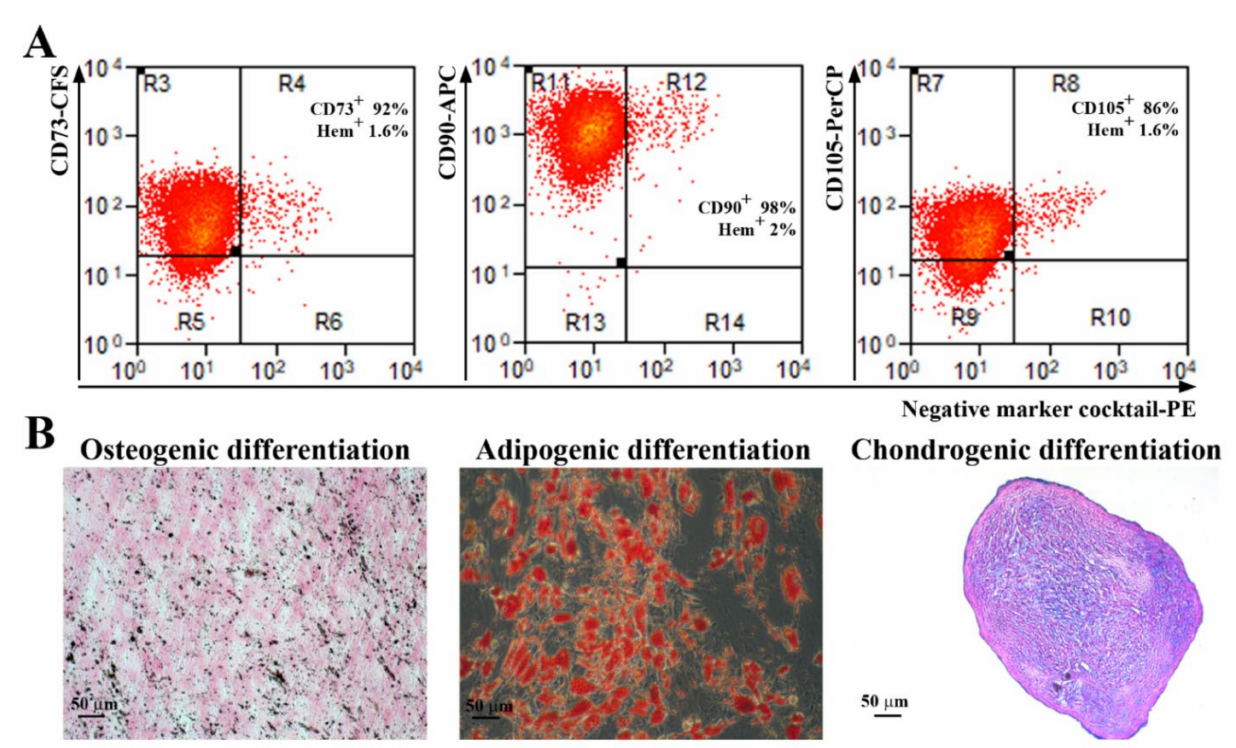
Figure 1. Characterization of human ADSC. ( A ) Representative flow cytometry histograms showing the expression of MSC-specific surface markers. It can be noticed that the cells were negative for the hematopoietic markers CD45, CD34, CD11b, CD79A, and HLA-DR, and positive for CD73, CD90, and CD105 ( n = 3). ( B ) Analysis of the multipotent capacity of ADSC by their ability to generate osteocytes (left, von Kossa staining), adipocytes (middle, Oil Red O staining), and chondrocytes (right, Alcian blue staining) when incubated in specific